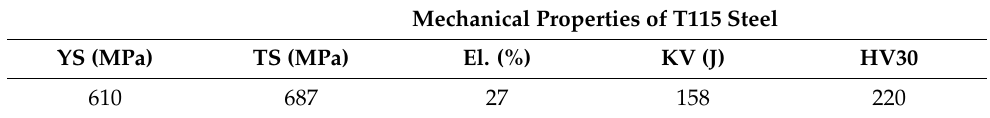
Table 2. Mechanical properties of T115 steel in as-received